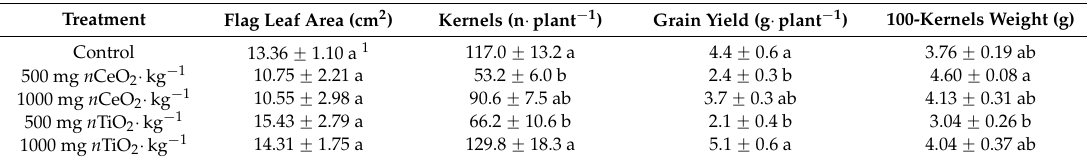
Table 2. Biometric and yield parameters of barley plants in soil treated with none (Control), 500 mg